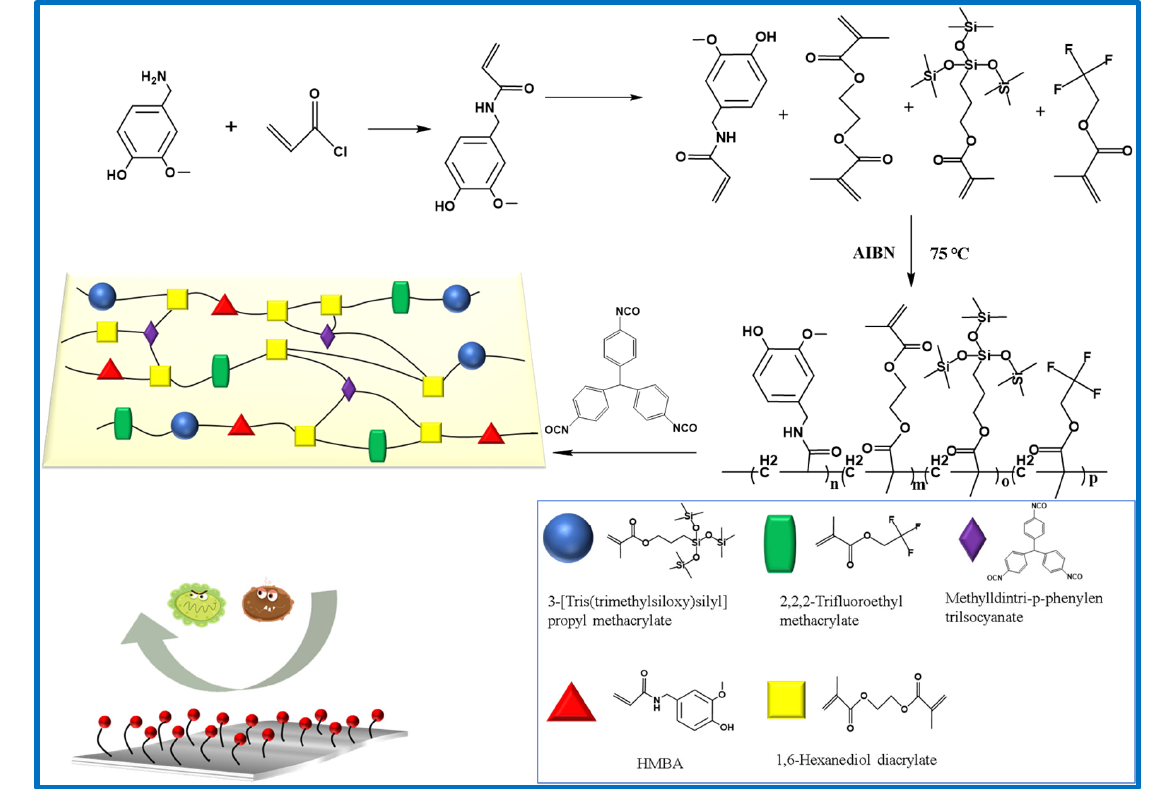
Figure 1. A schematic representation of the preparation of the PRE coating.